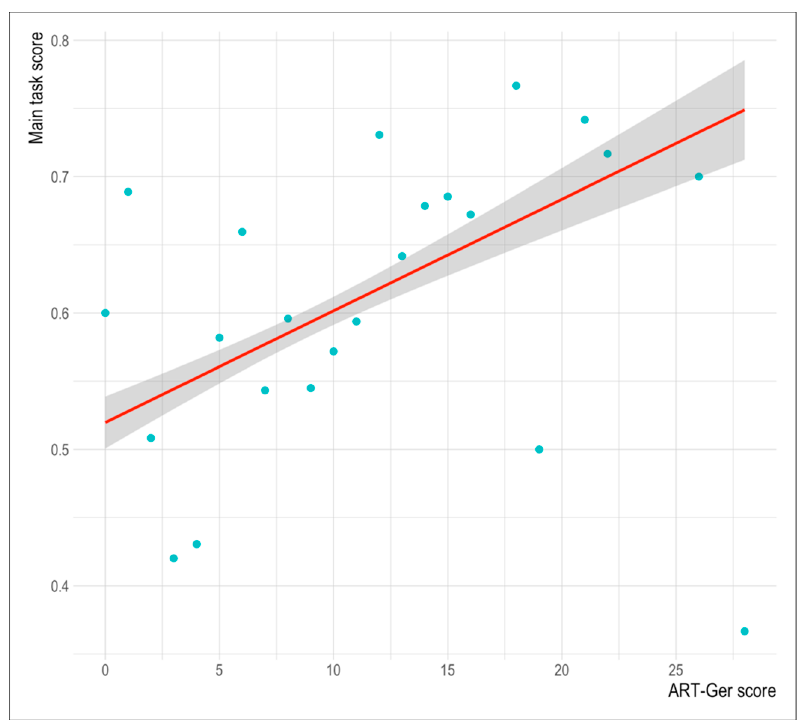
Figure 11. Relation between the scores in the main task and in the German author recognition task by the non-native participants .